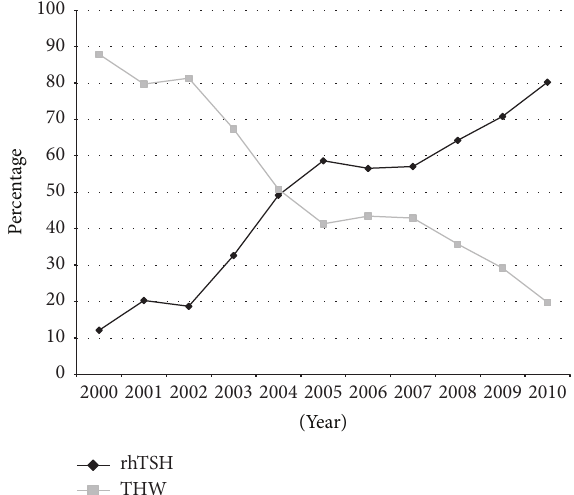
Figure 1: Distribution of RAI preparation (rhTSH versus THW) for patients with differentiated thyroid cancer that received radioactive iodine in the period from 2000 to 2010. Data for each year are obtained by combining all patients from all centers diagnosed in each year. rhTSH: recombinant human thyroid stimulating hor- mone; THW: thyroid hormone